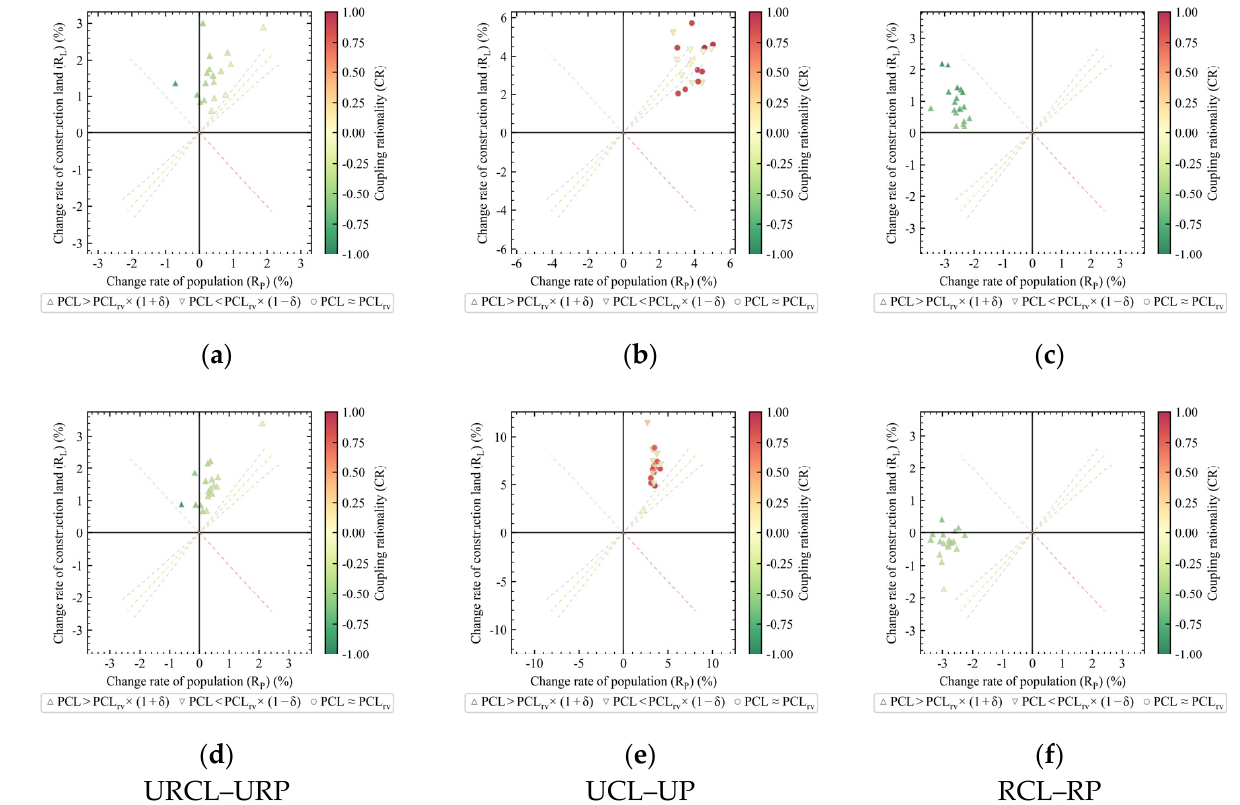
Figure 7. Coupling scatter plot of URCL and population in the prefecture-level cites of Henan province from 2010 to 2016: ( a ) coupling scatter plot of URCL and URP from 2010 to 2013; ( b ) coupling scatter plot of UCL and UP from 2010 to 2013; ( c ) coupling scatter plot of RCL and RP from 2010 to 2013; ( d ) coupling scatter plot of URCL and URP from 2013 to 2016; ( e ) coupling scatter plot of UCL and UP from 2013 to 2016; ( f ) coupling scatter plot of RCL and RP from 2013 to 2016.